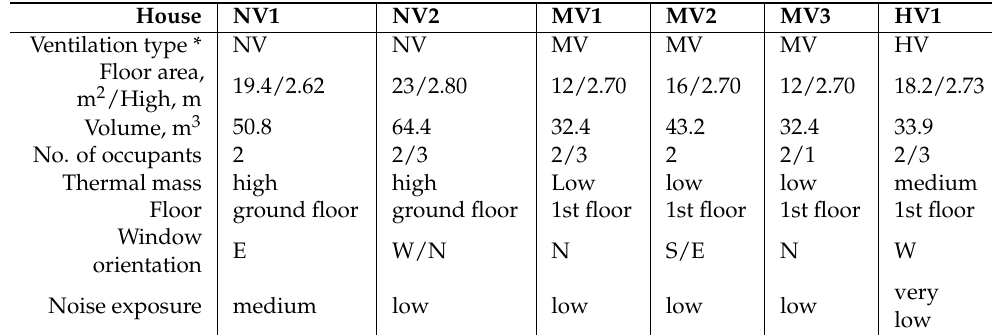
Table 1. Monitored bedrooms